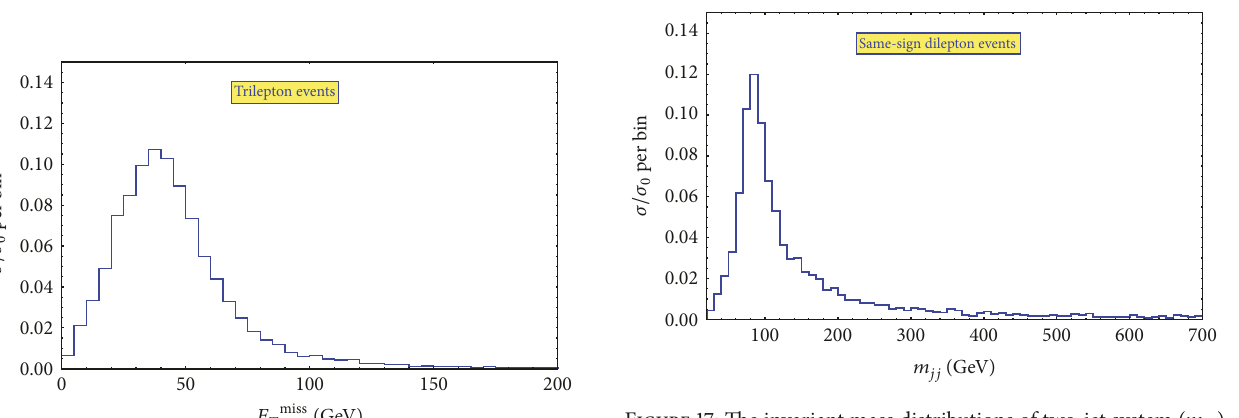
Figure 17: The invariant mass distributions of two-jet system (𝑚 𝑗𝑗 ) from the same-sign dilepton plus di-jet final state showing a peak around the 𝑊 mass (𝑚 𝑊 ) .